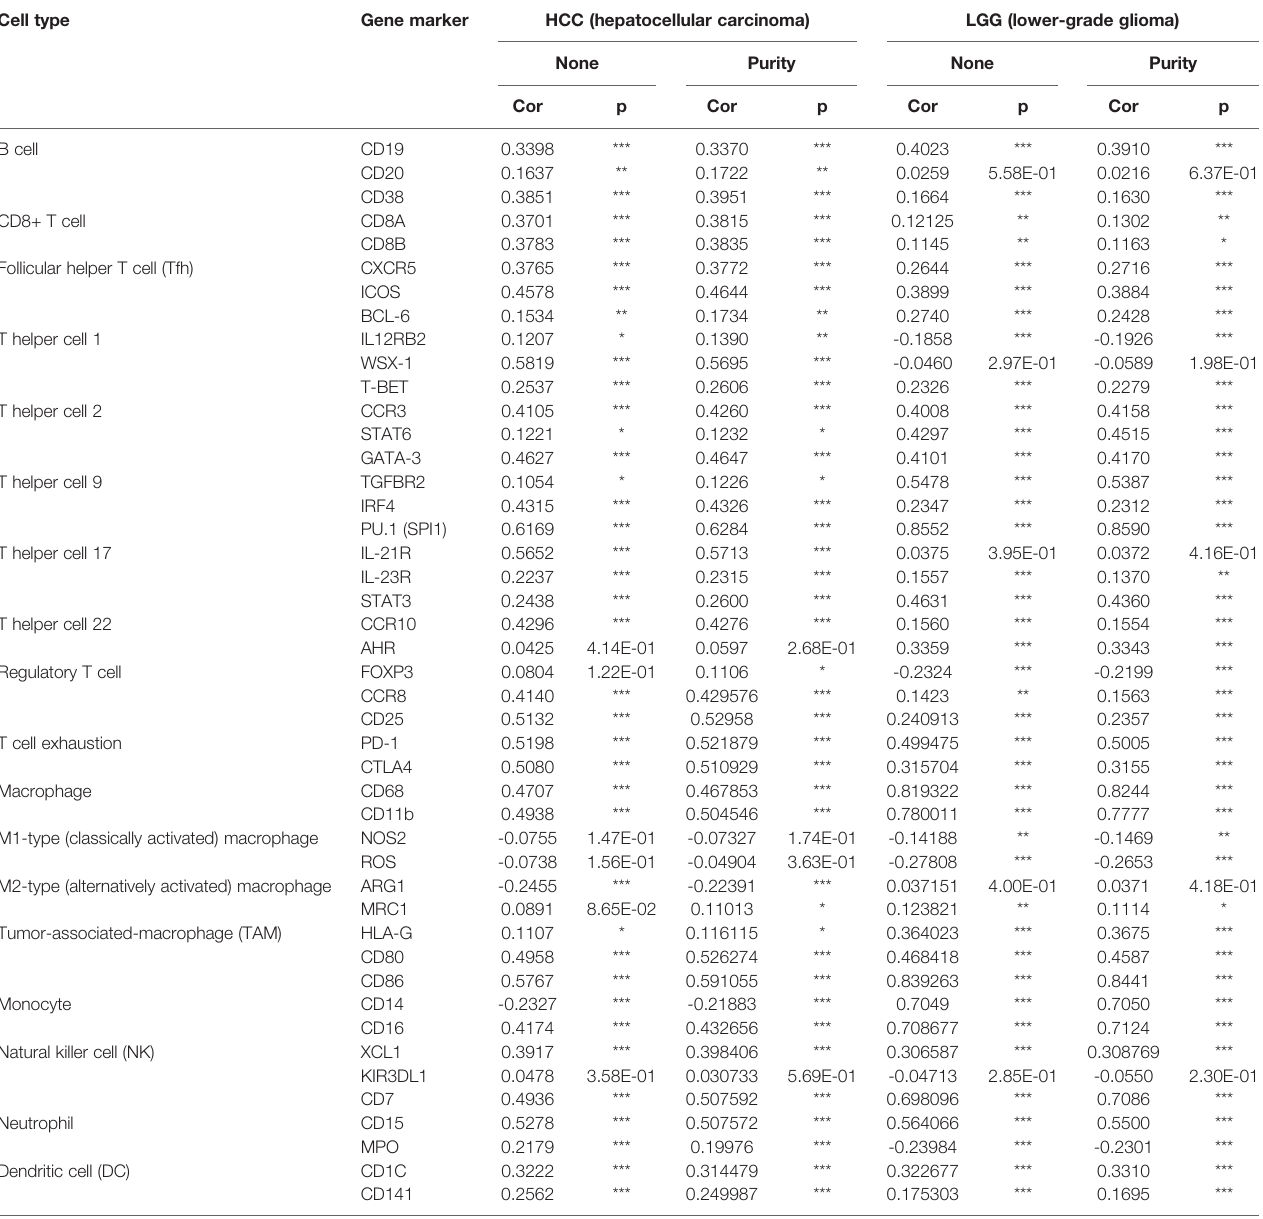
TABLE 2 | Correlation between SLC1A5 and gene-markers of immune cells in TIMER. Cell type Gene